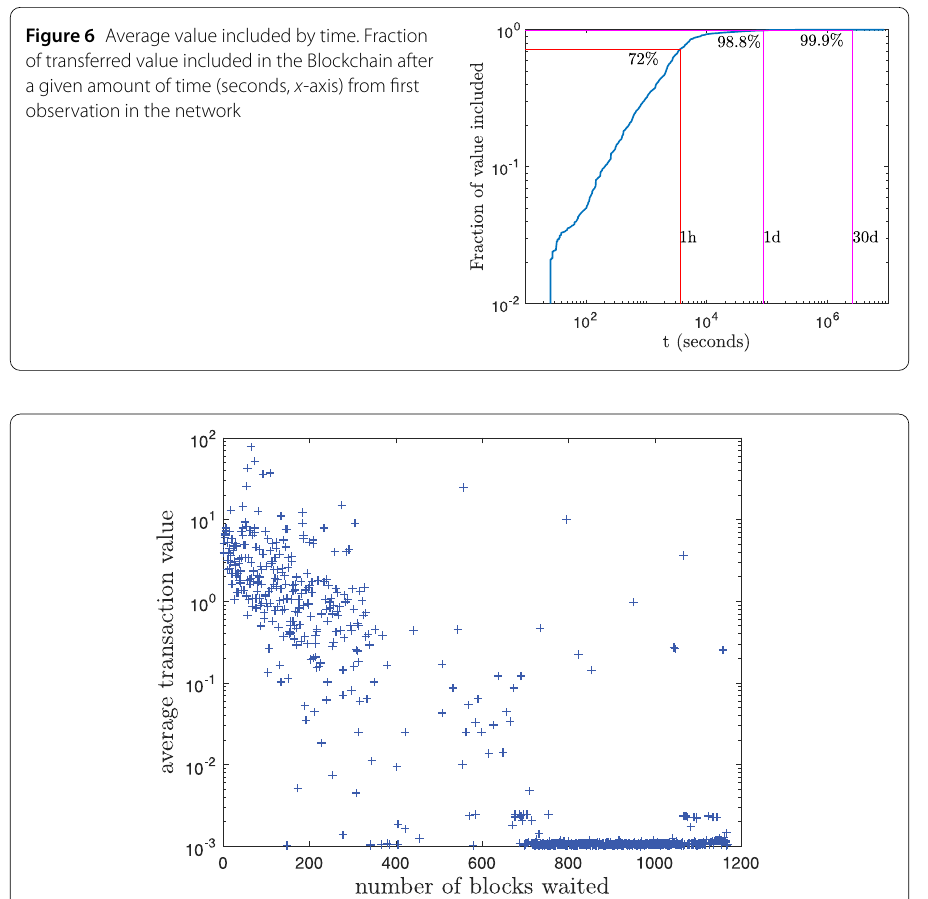
Figure 7 Value vs time. Average value of the transaction (in Bitcoins) vs. waiting time in blocks